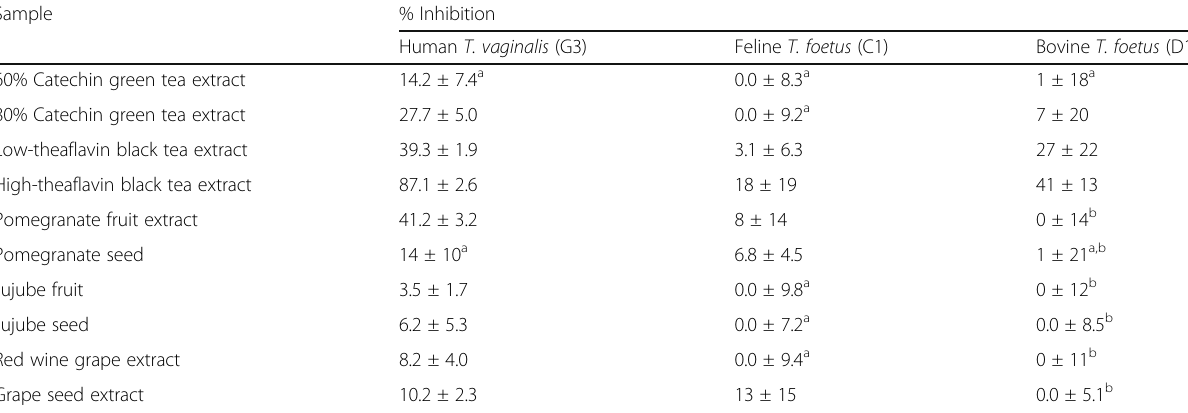
Table 2 Inhibition of parasite growth by natural plant preparations Sample